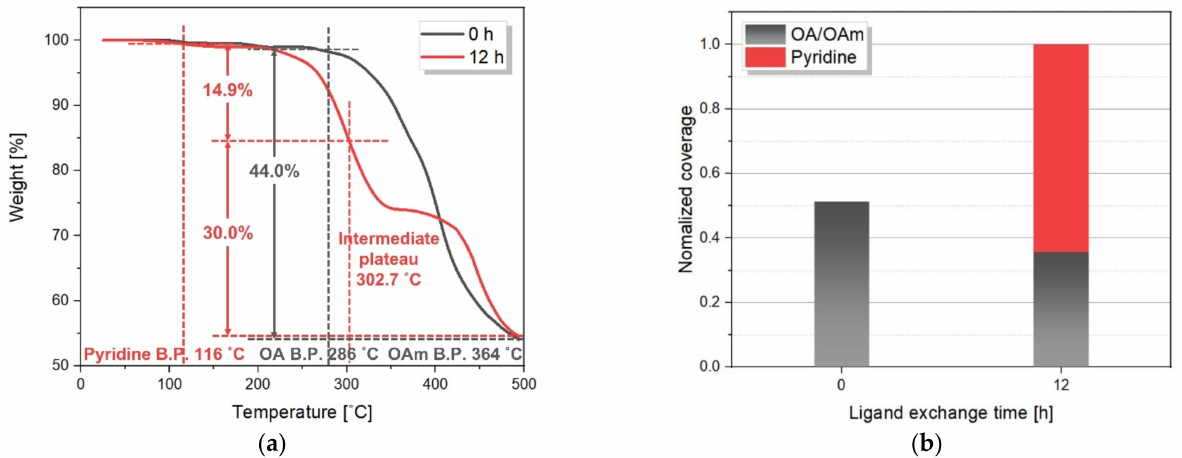
Figure 8. ( a ) The TGA graphs of the (0 and 12) h pyridine ligand exchange time, and ( b ) the normal- ized coverage ratio (OA/OAm- and pyridine capped) under the (0 and 12) h ligand exchange time. Figure 9a,b show the evaluation parameters (R S , mobility, defect density, CCD − DCD, and sensitivity) of the detectors prepared at different exchange times that were